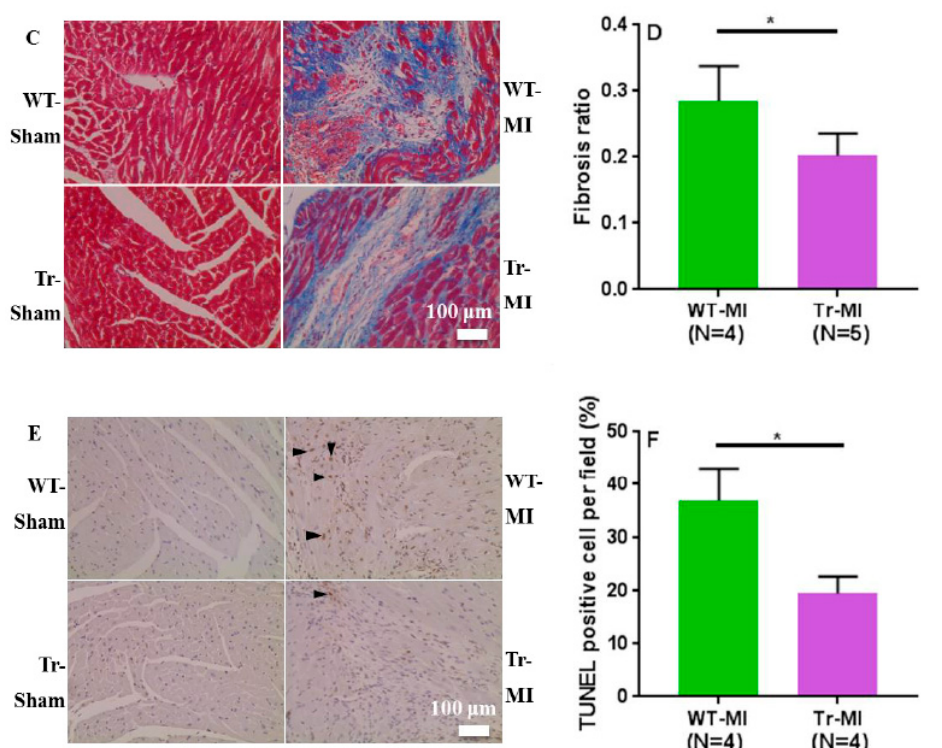
Figure 7. Paraffin-embedded cardiac sections of WT and Tr mice were stained using Masson’s Trichrome ( A,C ). ( A ) Shows whole slice of hearts, while ( C ) shows only infarct zones. Blue area indicates myocardial fibrosis, while red area indicates healthy muscle tissue. ( B ) Myocardial infarction size ratio and ( D ) myocardial fibrosis ratio were determined using MetaMorph 6.1 software. ( E ) Terminal Deoxynucleotidyl Transferase dUTP Nick End Labelling ( TUNEL)-positive nuclei of paraffin-embedded sections from the mice hearts indicated in ( A ). Apoptotic cells appear brown, while normal cells appear blue. ( F ) Measurement of TUNEL-positive nuclei in cardiac sections from mice indicated in ( A ). ( G ) Measurement of reactive oxygen species (ROS) ratio using chloro methyl- 2’,7’-dichlorodihydrofluorescein diacetate (CM-H 2 DCFDA) staining from mice frozen cardiac sections. * Indicates p ≤ 0.05.